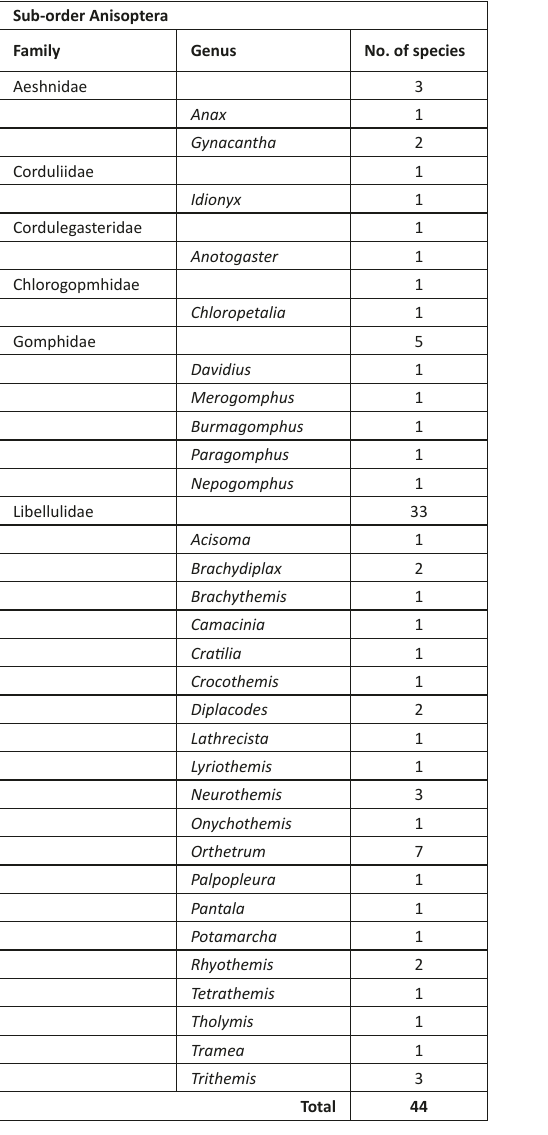
Table 4. A taxonomic summary of odonates of